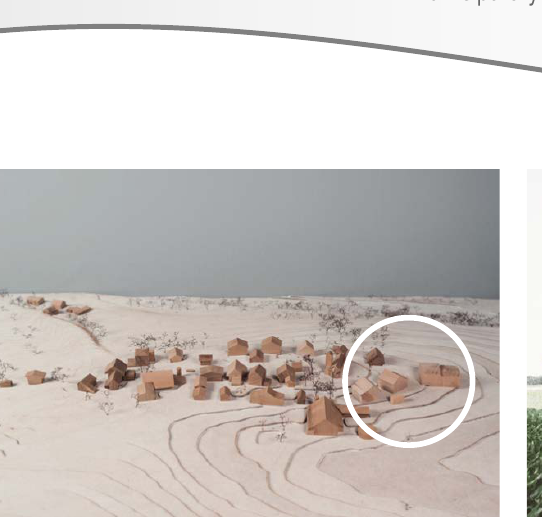
Figure 10. Development proposal for an old barn Figure 11. Development proposal for an old barn